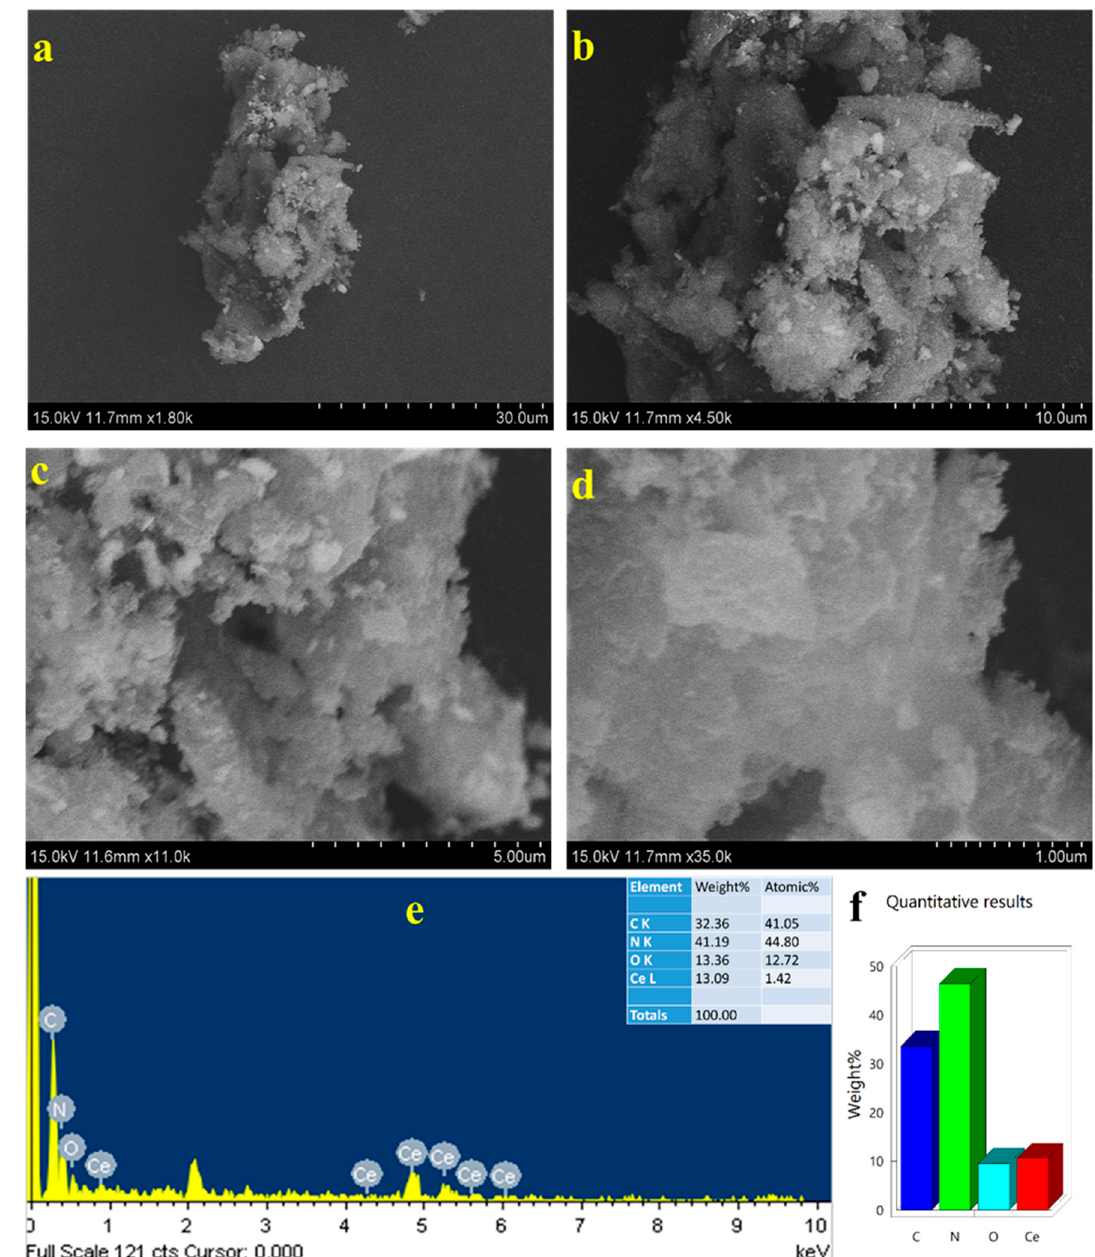
Figure 2. Different magnifications of FESEM images ( a – d ) and ( e , f ) EDX of CeQDs/CN-3 nanostructure.